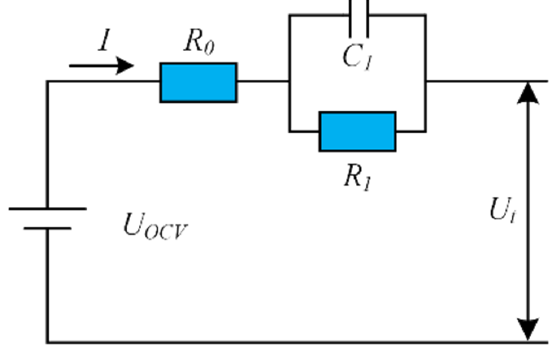
Figure 2. First ‐ order RC equivalent circuit